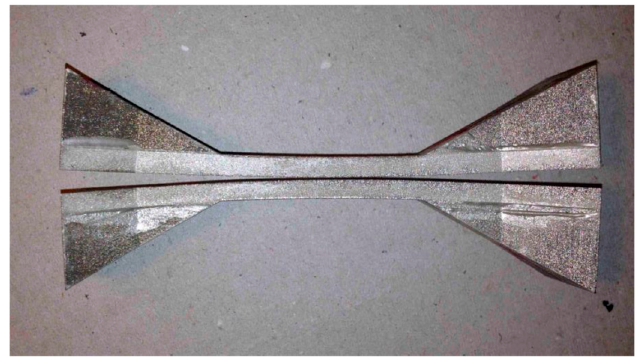
Figure 12. Deformation of the sample after cutting.